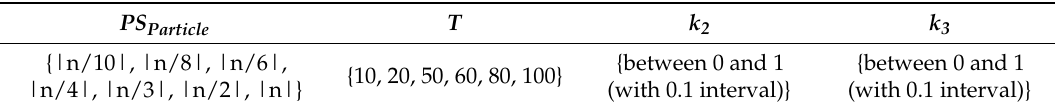
Table 3. Different values of parameters used in experimental